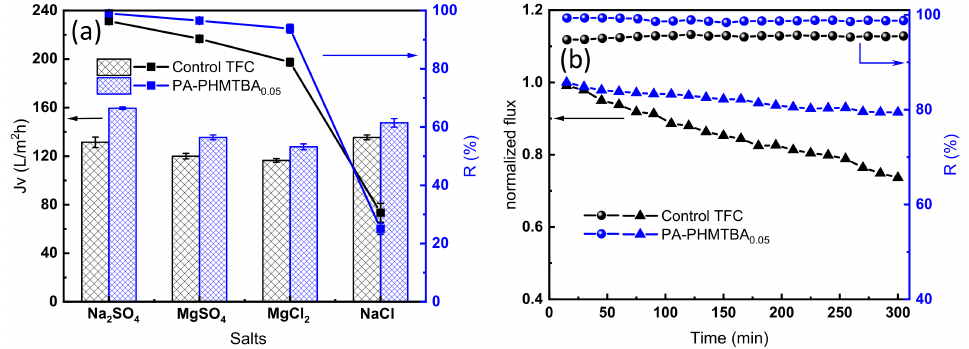
Figure 8. ( a ) Selectivity for different inorganic salt solutions and ( b ) stability of the control TFC membrane and the PA-PHMTBA 0.05